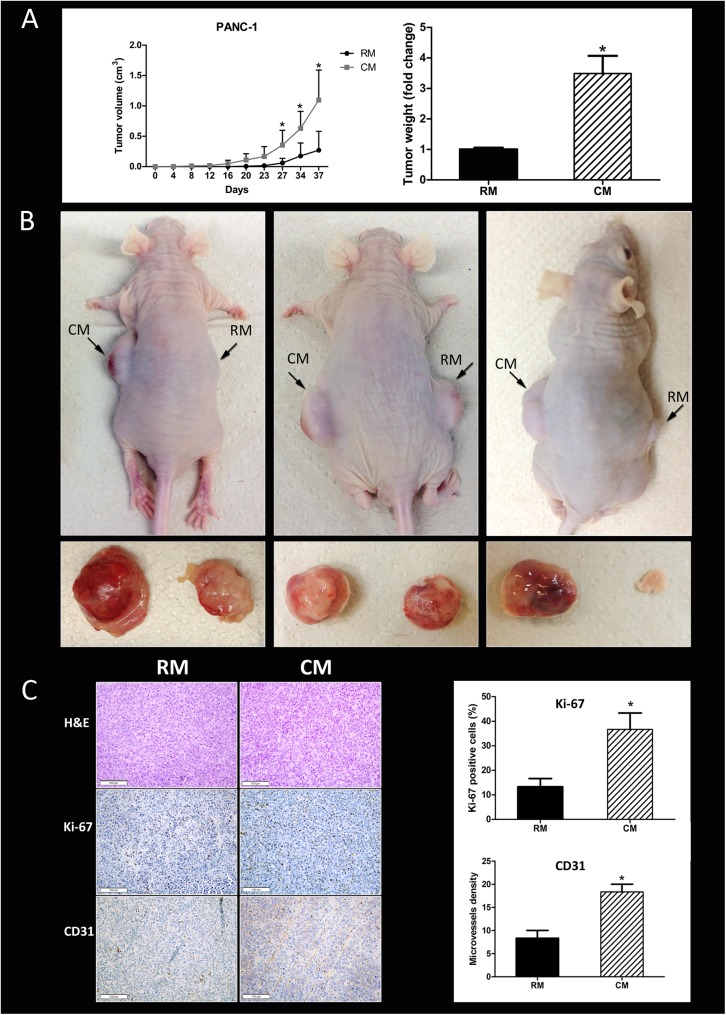
Tumor growth is promoted by omental fat in vivo.(A) Facilitation of tumor growth and weight of PANC-1 tumors in mice following pre-treatment with omental fat CM (n = 15). Graphs represent the average of three repeated experiments ±SD (P< .05); (B) Representative tumor and mice images. (C) Marked increase in proliferation (Ki-67) and microvessel density (CD31) by human omental fat CM. Representative immunohistochemistry (IHC) images are shown on the left (H&E, x200; Ki-67, x200; CD31, x200). IHC quantification is shown on the right. n = 10 in tissues of each site; Scale bar = 100 μm.